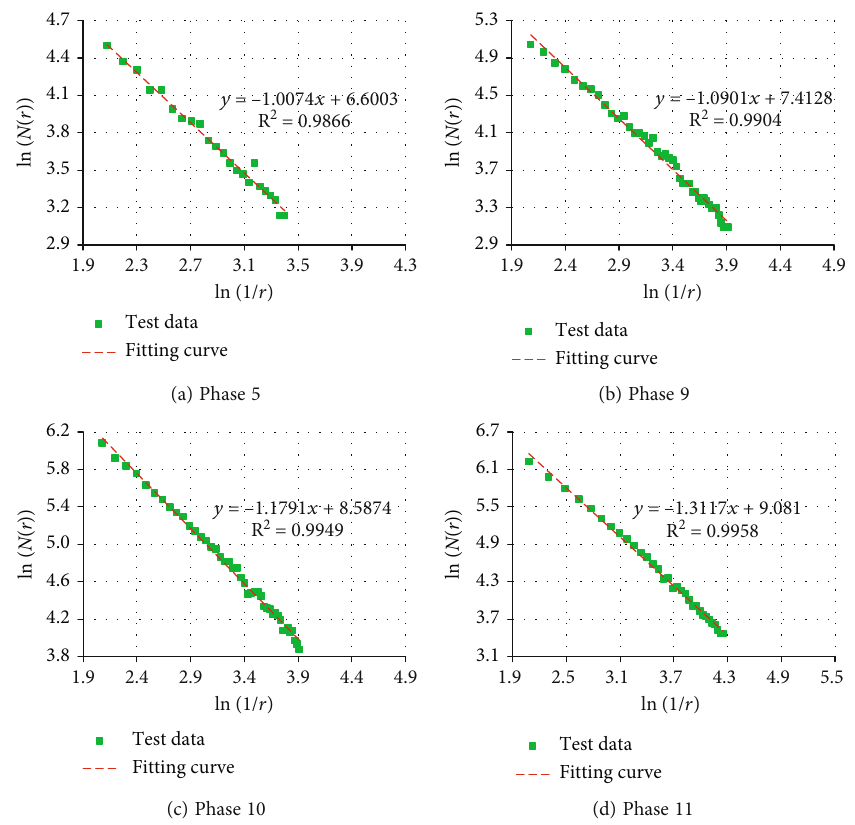
Figure 10: Curve chart of fractal dimension calculation for fractures in di ff erent loading